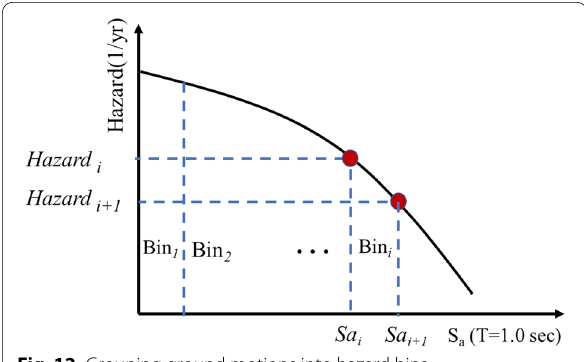
Fig. 12 Grouping ground motions into hazard